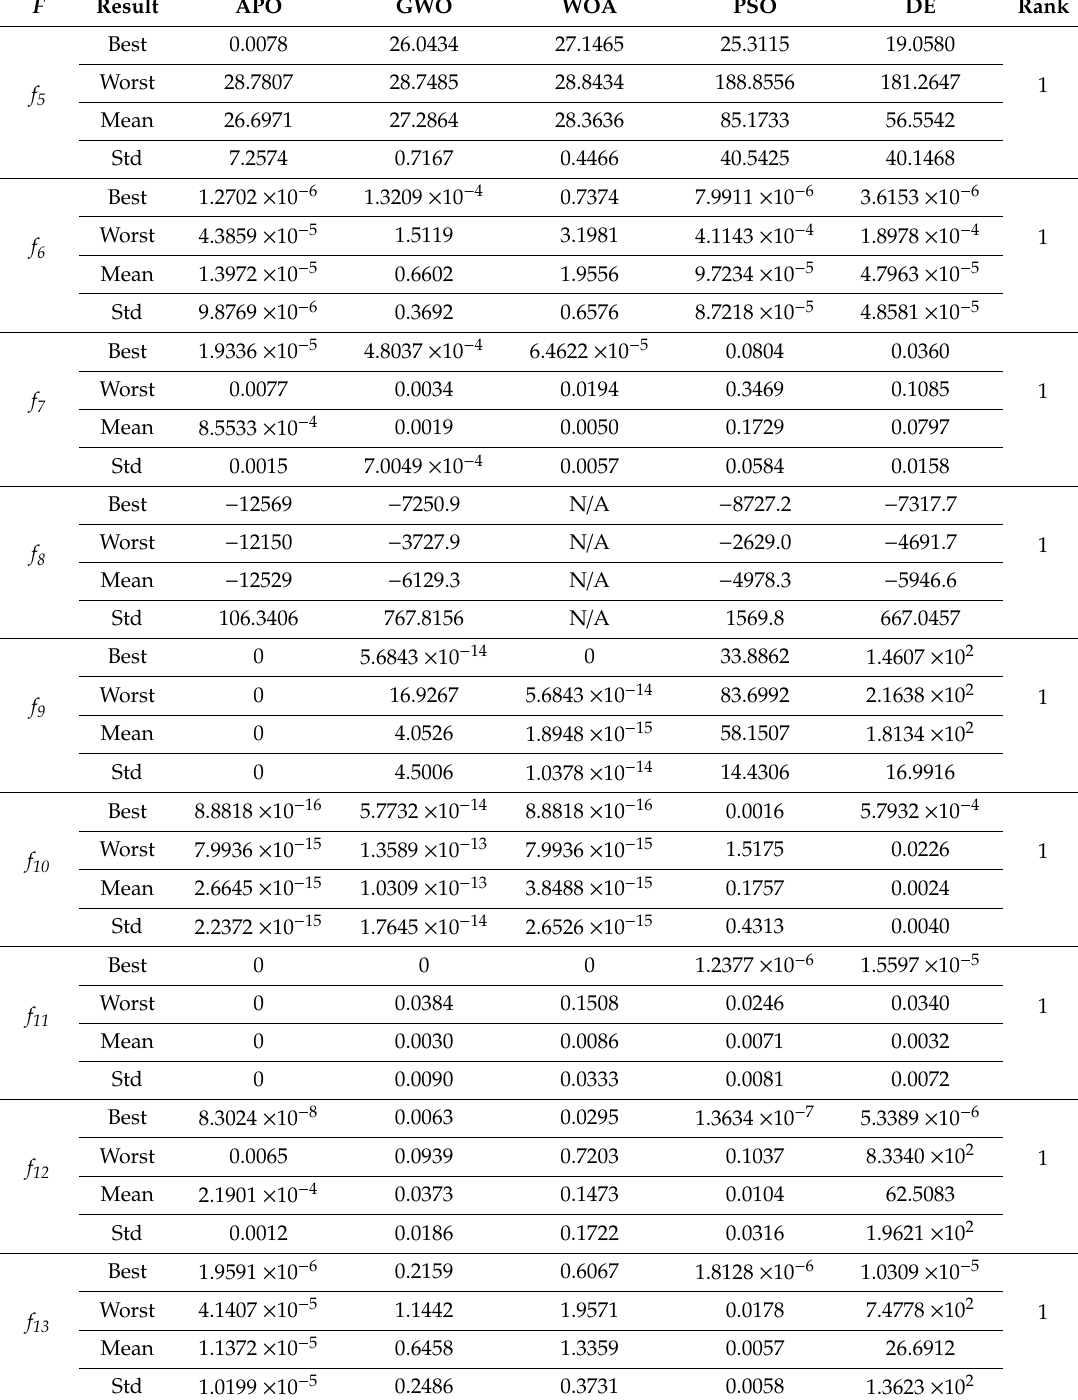
Table 6. Compared with the other four algorithms, APO exhibited the best performance on f 15 , f 21 , f 22 and f 23 . For f 16 and f 17 , each algorithm nearly found all the best values. From Table 6, there is almost no di ff erence in the performance on f 18 , f 19 and f 20 of each algorithm. In addition, although APO performs moderately on f 14 , it can also find the optimal value most of the